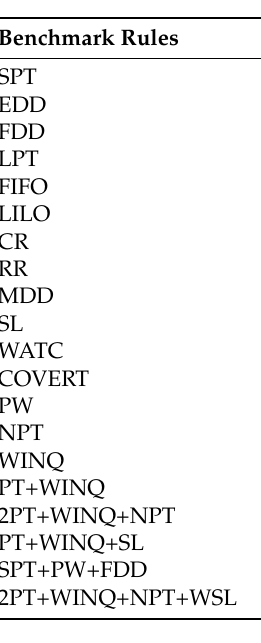
Table 4. Benchmark dispatching